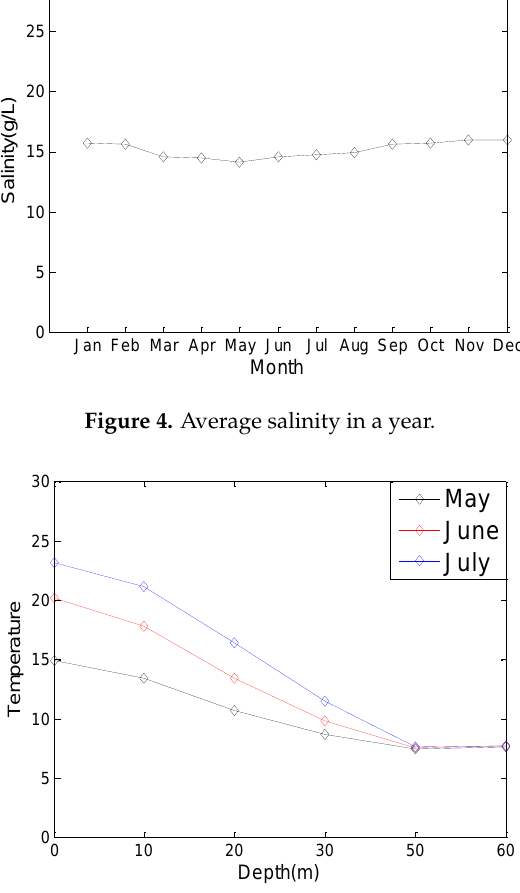
Figure 5. Average temperature with different water depths.